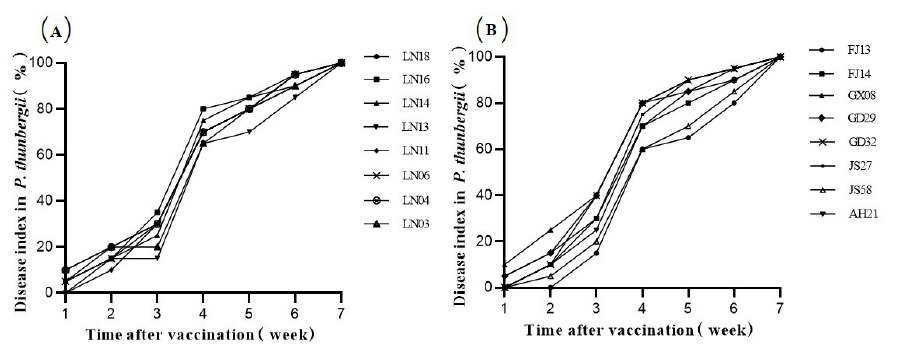
Figure 3. Symptoms of P. thunbergii after artificial inoculation with 16 strains of PWN.